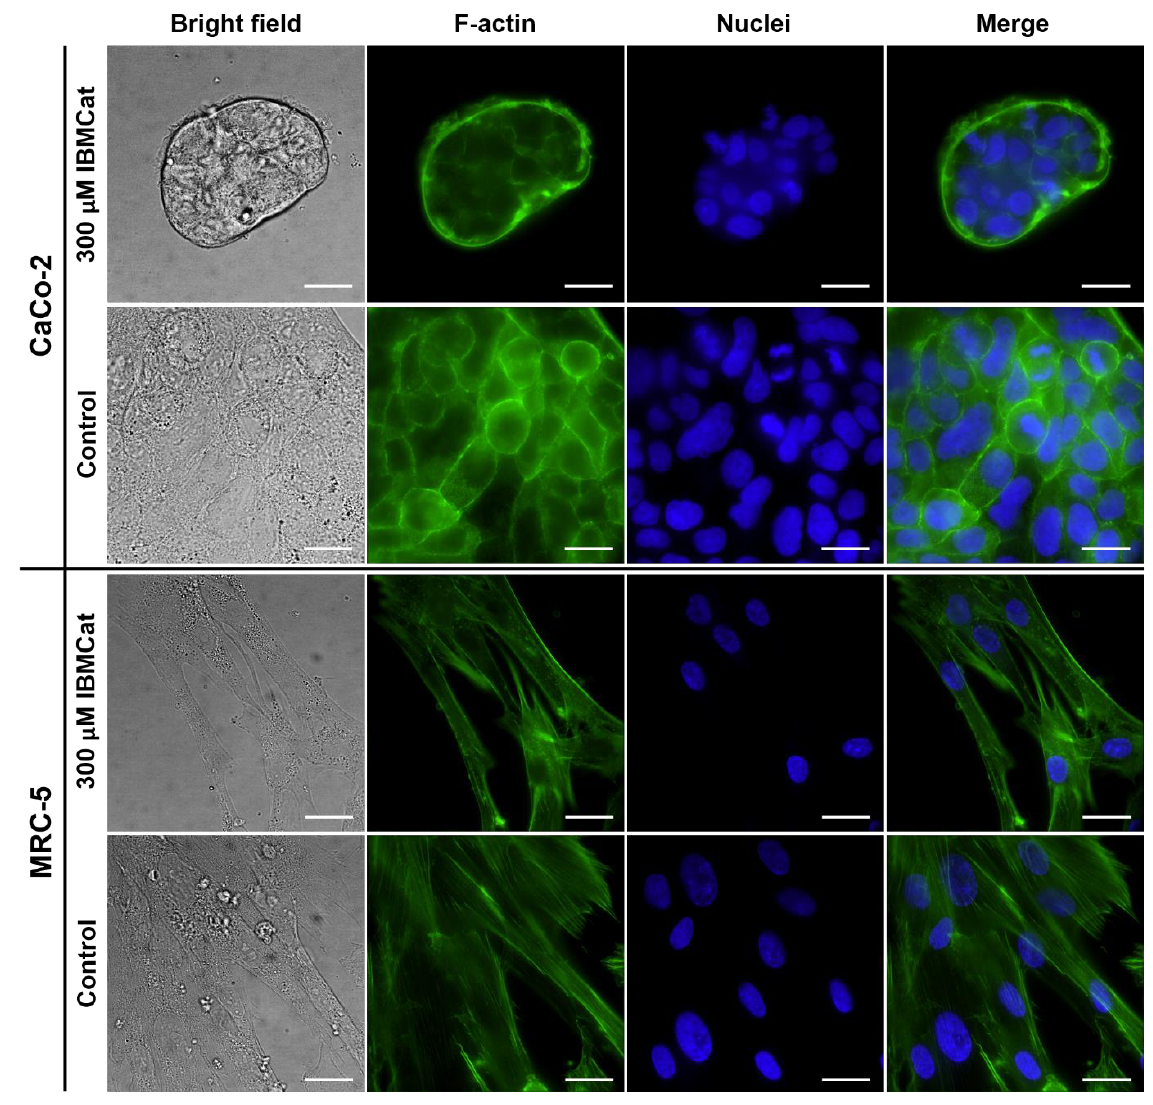
Figure 7. Fluorescence microscopy images of human cells derived from colon carcinoma (CaCo-2) and human primary fibroblasts (MRC-5) treated with 100 – 500 µM concentration of 4-isobutylmethcathinone (IBMCat) for 24 h. Individual columns from left: bright-field images, F-actin labeled with phalloidin-Atto 488, cell nuclei stained with DAPI, and merges of the fluorescent images. The scale bars correspond to 20 µm.